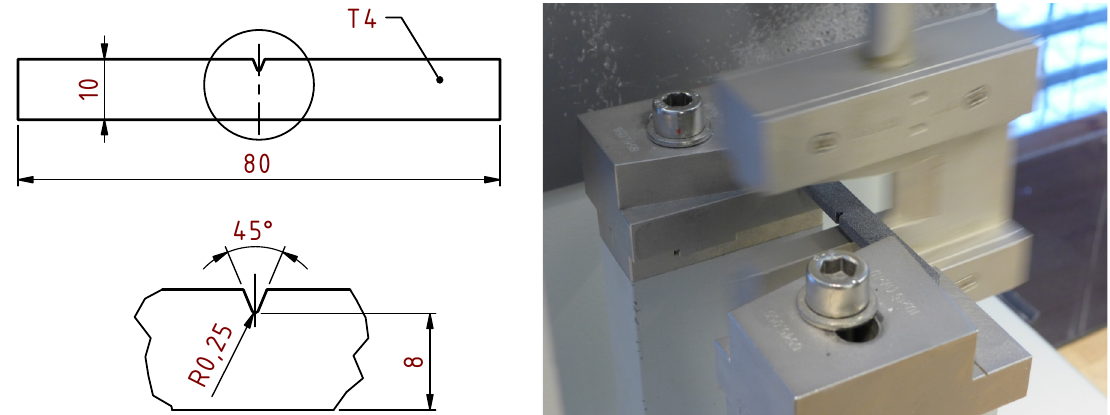
Figure 10. Notched specimen for impact